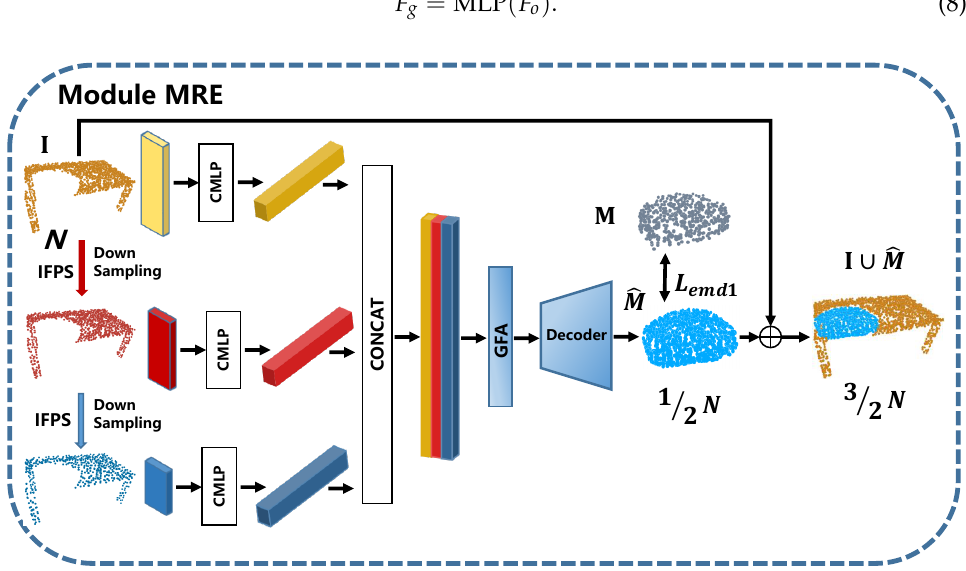
Figure 4. The 3DPCTN-MRE encoder first performs IFPS sampling on the input point cloud to obtain multi-scale features with resolution of [2048, 1024, 512]. Then, multi-scale feature representations are fed into the missing-part network decoder to obtain a completed shape point cloud ˆ M